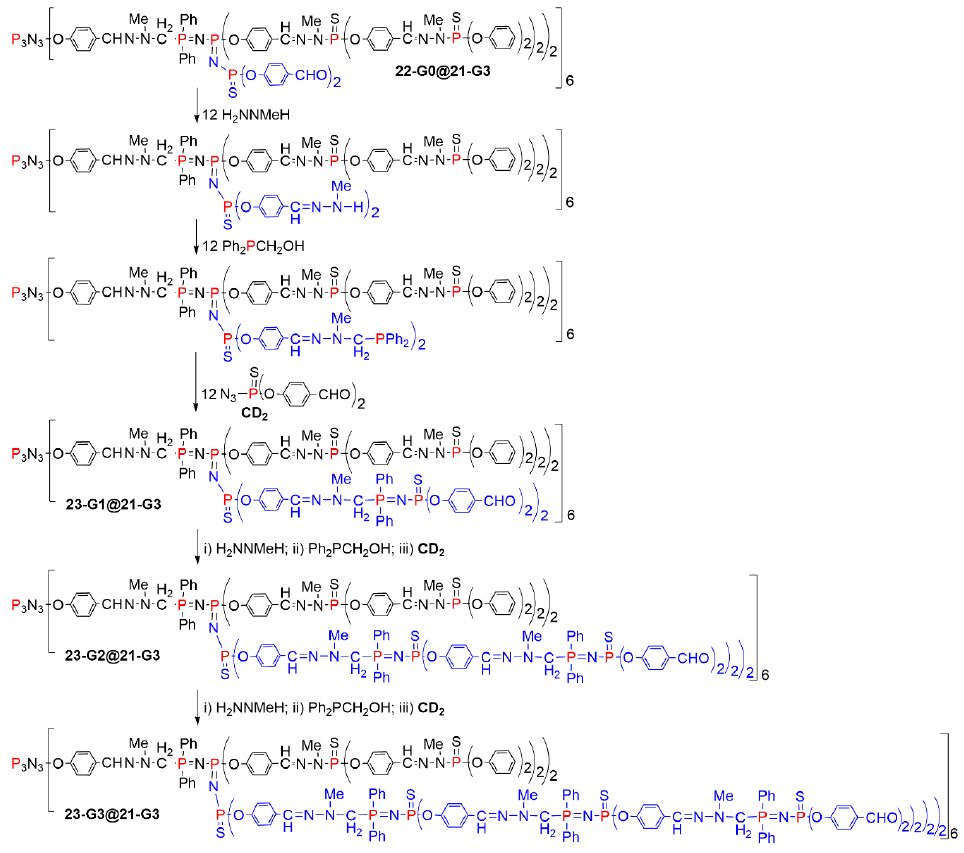
Scheme 23. A three-step method for growing new branches inside a dendrimer, up to 23-G3@21-G3 .